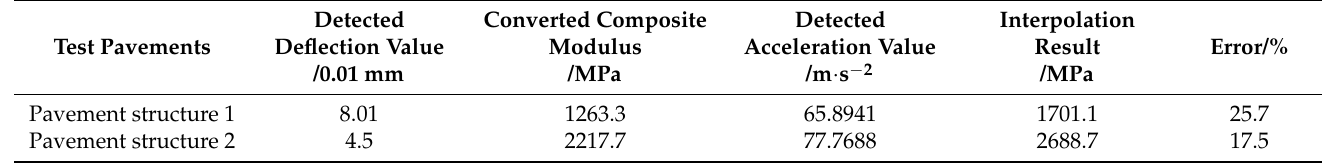
Table 5. Comparison between deflection test results of Benkelman beam and test